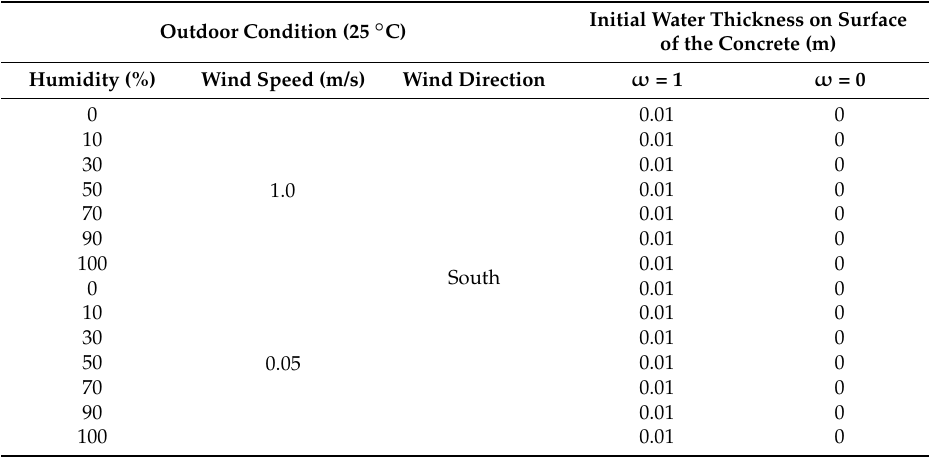
Table 4. Initial conditions of the film thickness of water on surface of the concrete for the CFD analysis.